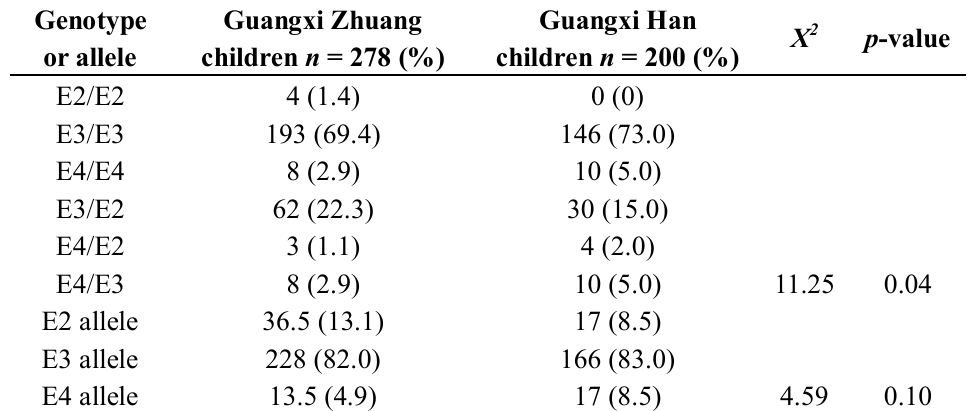
Table 2. The frequencies of APOE genotypes and alleles in the Guangxi Zhang and Han children